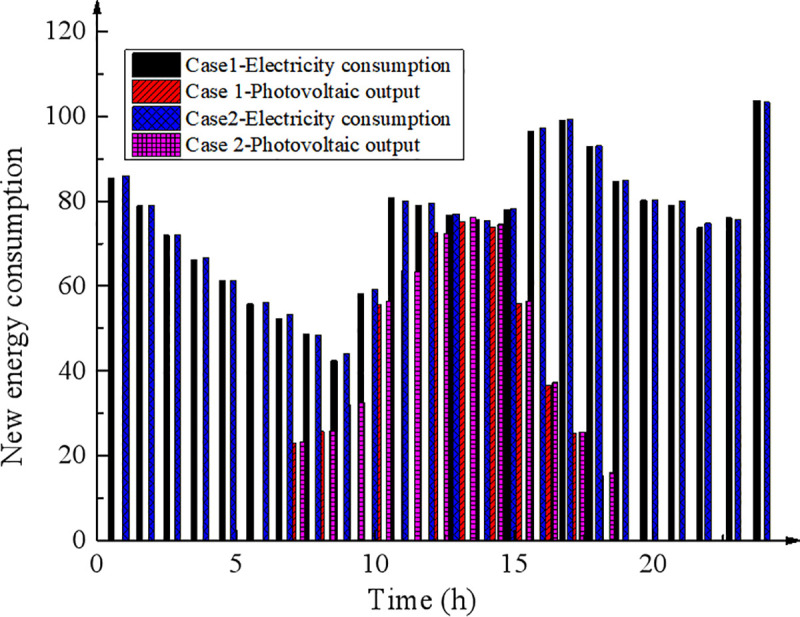
New energy consumption situation of the power information system based on Case 1 and Case 2.